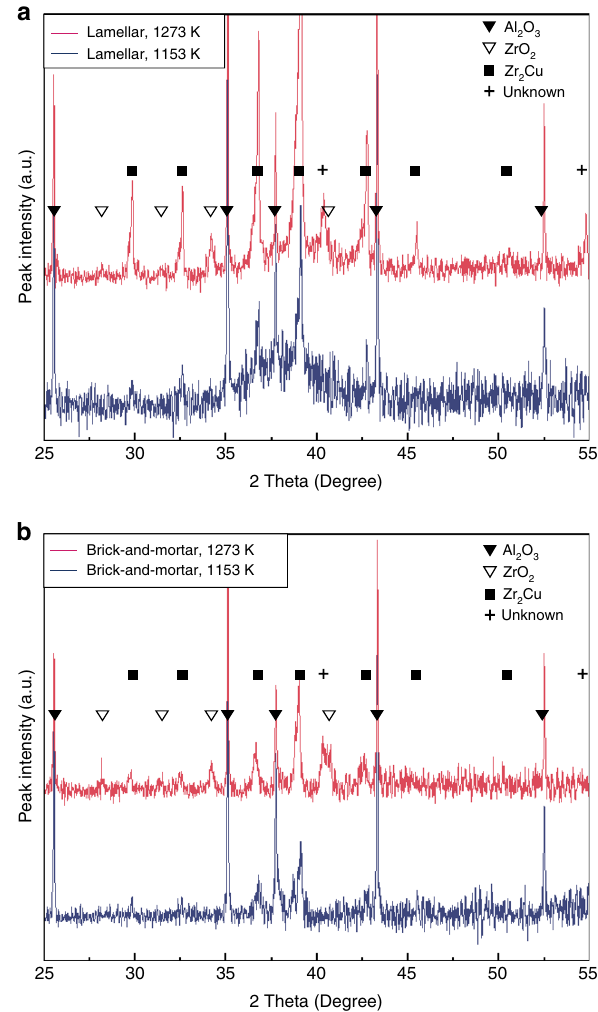
Fig. 3 X-ray diffraction (XRD) of compliant-phase ceramics. a , b XRD patterns of the alumina/BMG compliant-phase ceramics, with a lamellar structure ( a ) and brick-and-mortar structure ( b ), in fi ltrated at 1153 and 1273 K. In both curves, the dominant peaks of alumina and Zr 2 Cu were superimposed on the broad diffuse scattering, indicating the presence of an amorphous phase in the metallic mortar after the melt in fi ltration followed by water quenching. The results indicate that the phase constitution of the alumina/BMG-forming materials is dependent on the in fi ltration temperature, but independent of the alumina volume